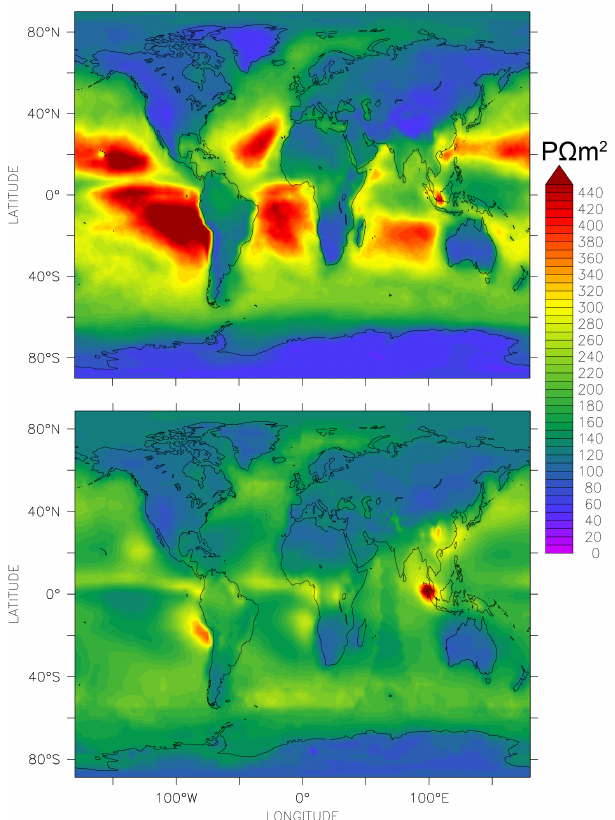
Figure 5. CESM1(WACCM) (top) and ISCCP (bottom) average column resistance (P (cid:127) m 2 =10 15 (cid:127) m 2 ), taking the current diver- gence/convergence phenomenon into account ( η = 1 /